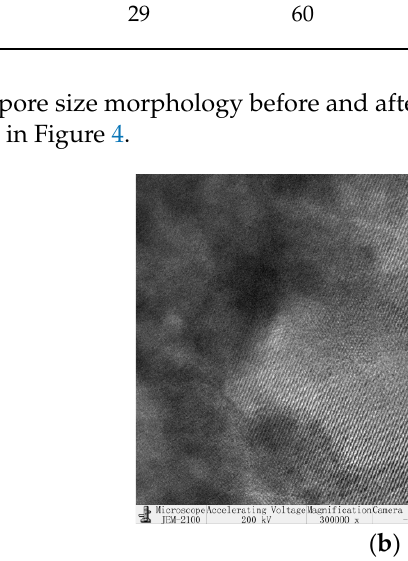
Figure 4. Changes in pore morphology of spent FCC catalysts before and after modification. ( a ) Before modification; ( b ) after modification.